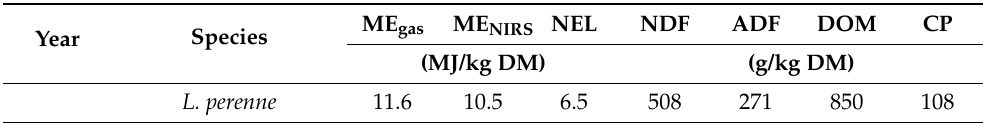
Table 2. Chemical composition and energy content of the species evaluated, harvested in 2018 and